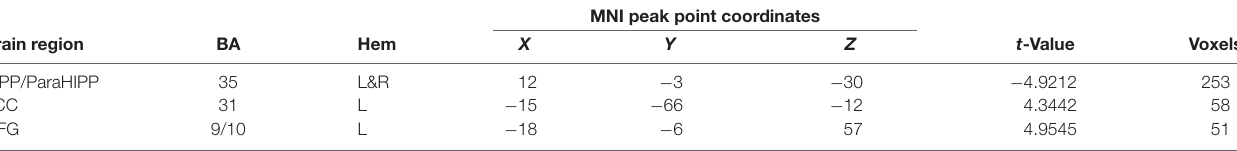
TABLE 2 | ALFF alterations between the UC and HC groups.